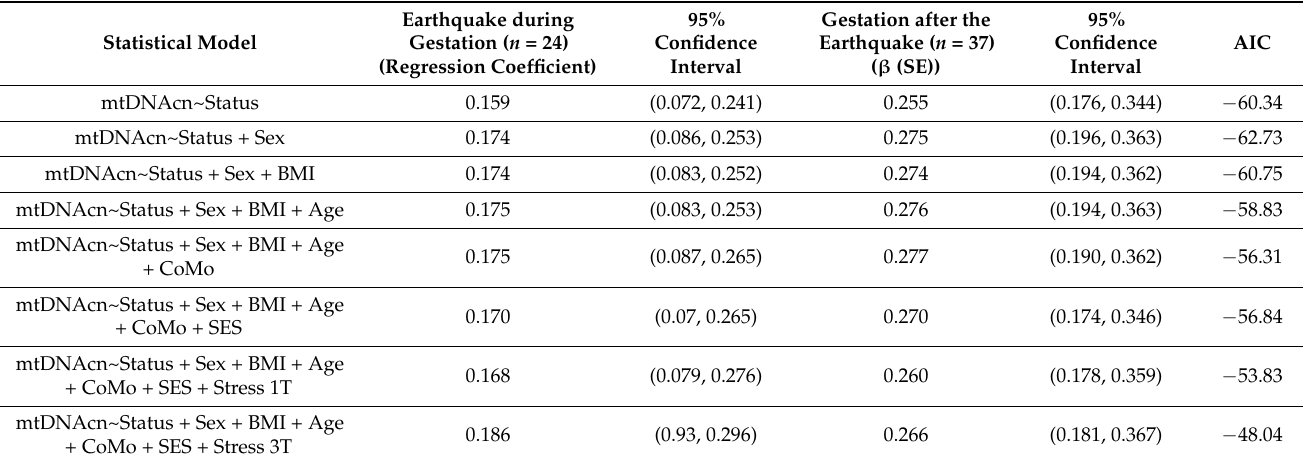
Table 2. Association between earthquake exposure and newborn umbilical cord mtDNAcn, progressively adjusted for covariates. The infants born before the earthquake were the reference group. Statistical Model